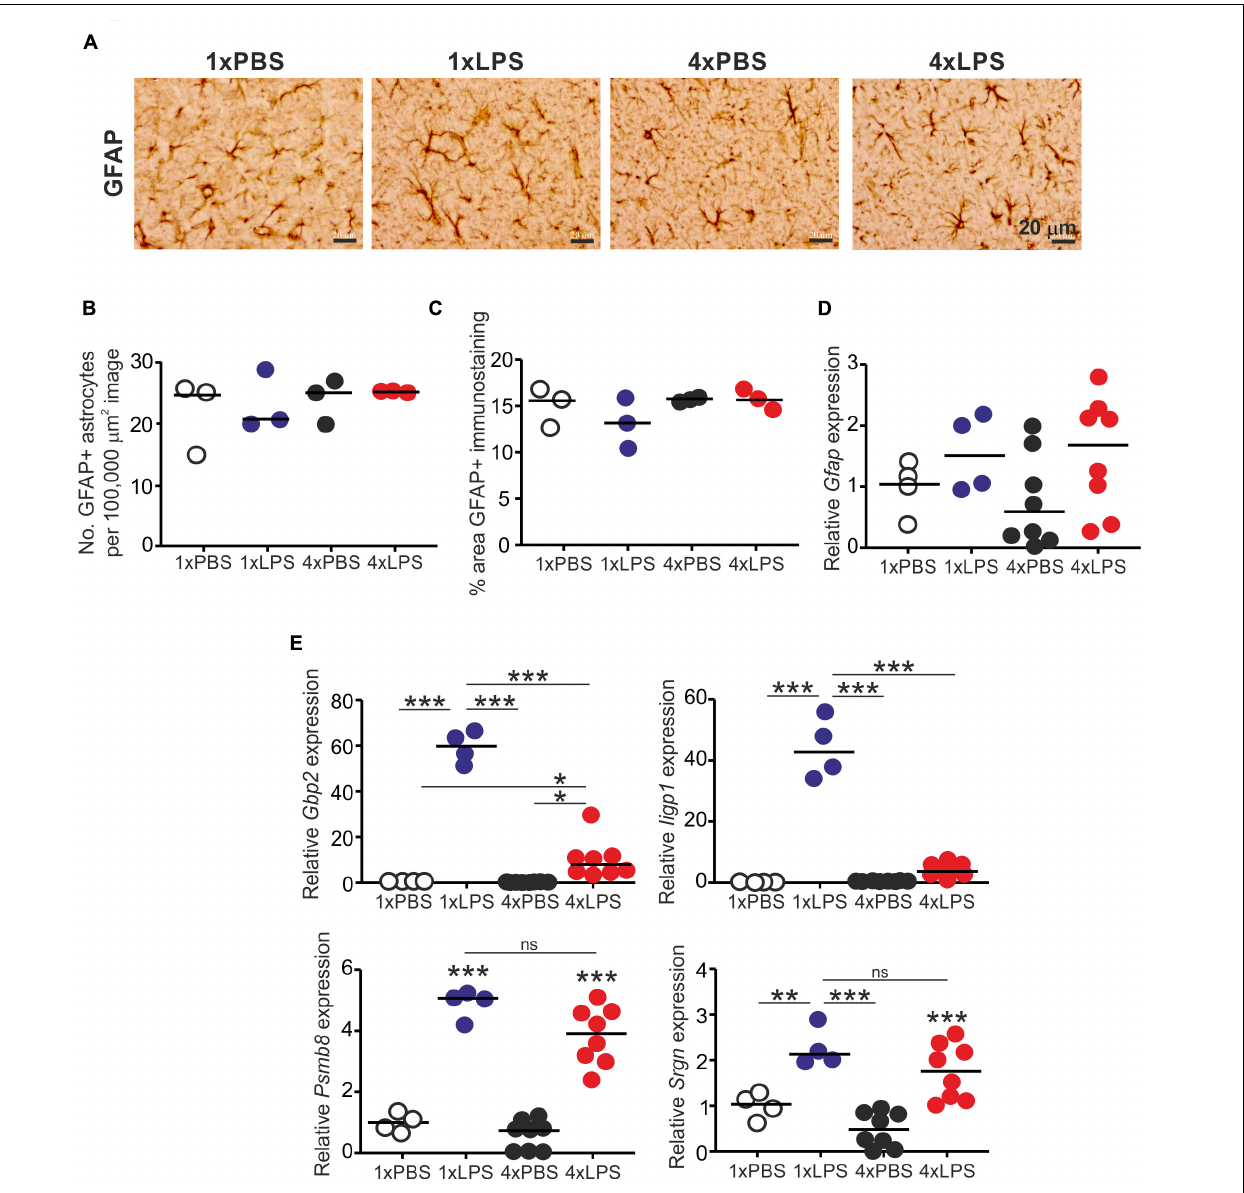
FIGURE 4 | Effect of systemic LPS treatment on astrocytes. Mice were given a single (1x) or four (4x) daily IP injections with either LPS or PBS (control) and brains collected 3 h after the final injection. (A) Representative immunostaining of GFAP + astrocytes (brown) in the CA1 region of the hippocampus striatum radiatum of each mouse. Scale bar 20 µ m. (B) Relative abundance of GFAP+ astrocytes in 100,000 µ m 2 images of the CA1 region of the hippocampus striatum radiatum of mice from each group. (C) Comparison of the magnitude of the GFAP+ immunostaining in the CA1 region of the hippocampus striatum radiatum of mice from each group. (D) Relative expression level of Gfap mRNA in half brains from each mouse from each group. (E) Relative expression level of Gbp2 , Iigp1 , Psmb8, and Srgn mRNA in half brains from each mouse from each group. Gene expression data are normalized so that the mean level in the 1xPBS controls was 1.0. N = 3–8 mice/group; horizontal bar in histograms, median. * P < 0.05; ** P < 0.01; *** P < 0.001; ns, not significantly